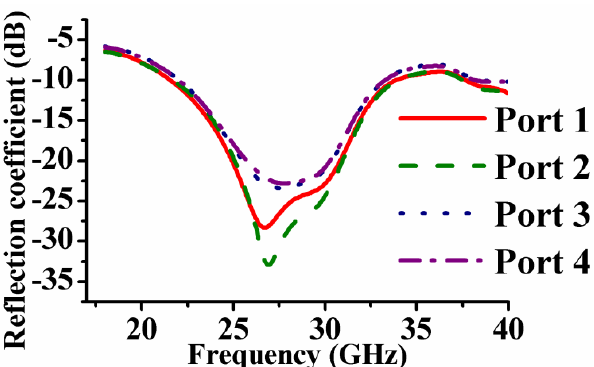
Figure 2: Reflection coefficients of proposed pattern diversity antenna.